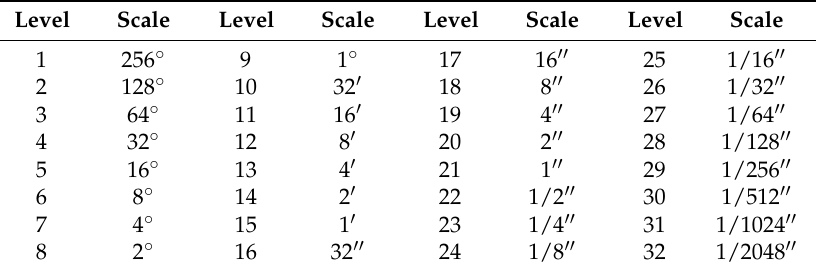
Figure 1. Geographic coordinate Subdivision grid with One-dimensional integral coding 2 n -Tree (GeoSOT) subdivision and coding method. Table 1. GeoSOT grid scale of different levels.